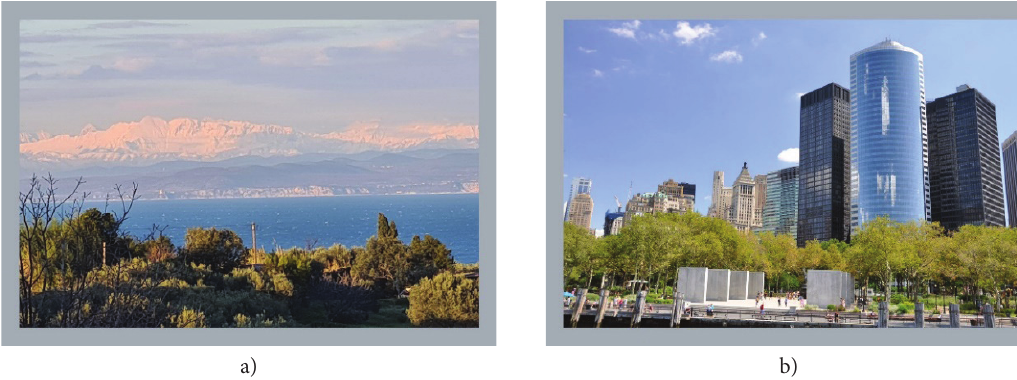
Figure 1. Examples of natural and urban view without negative characteristics: a) View 3 shows a dense vegetation in the foreground and snow-capped mountains in a distance with clearly visible boundary between the sea and land. Fascination and being away prevail; b) View 33 is a panoramic view on urban structure with natural elements (trees in a park) in the foreground and sky above. Compatibility and Lynch’s visual qualities form simplicity and clarity of joint prevail